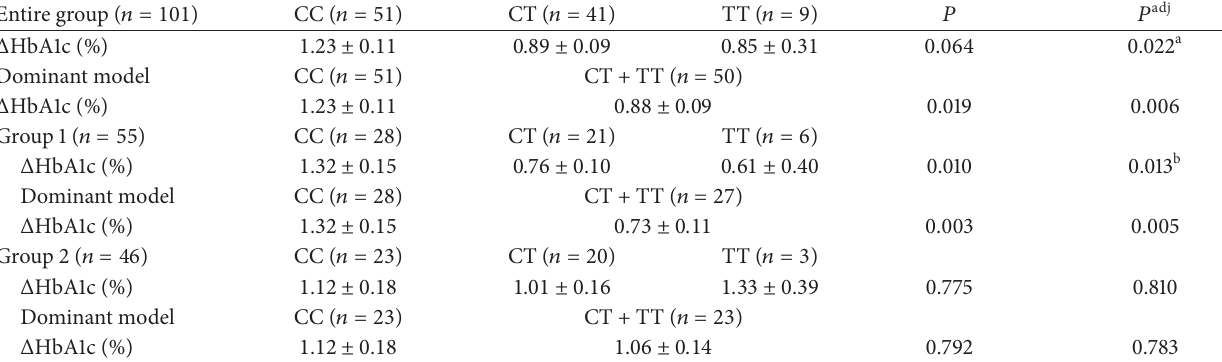
Table 3: Effect of the different sulfonylurea derivatives on Δ HbA1c with respect to TCF7L2 genotypes. Entire group ( 𝑛 = 101